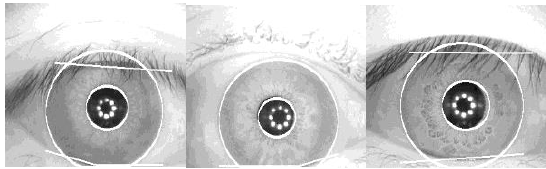
Figure 6. Boundaries between iris and eyelids localized for three eye